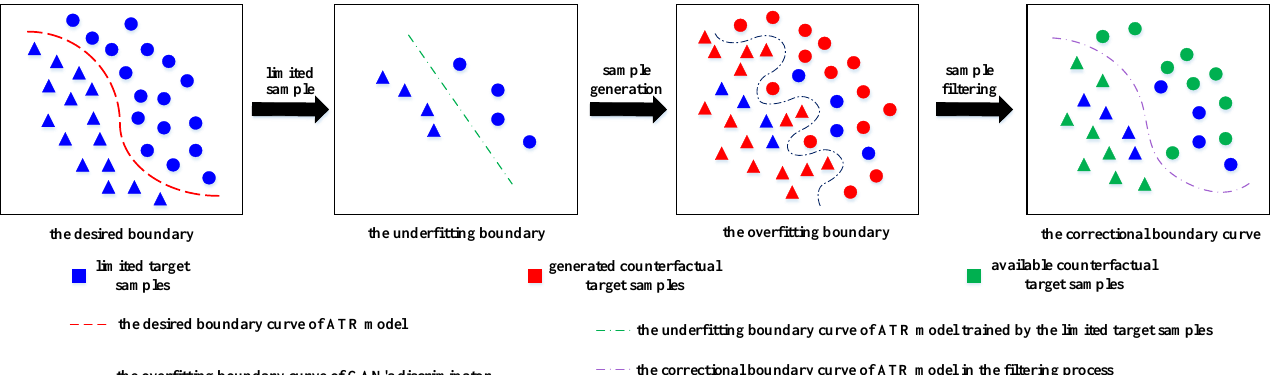
Figure 2. The implementation motivation about the proposed